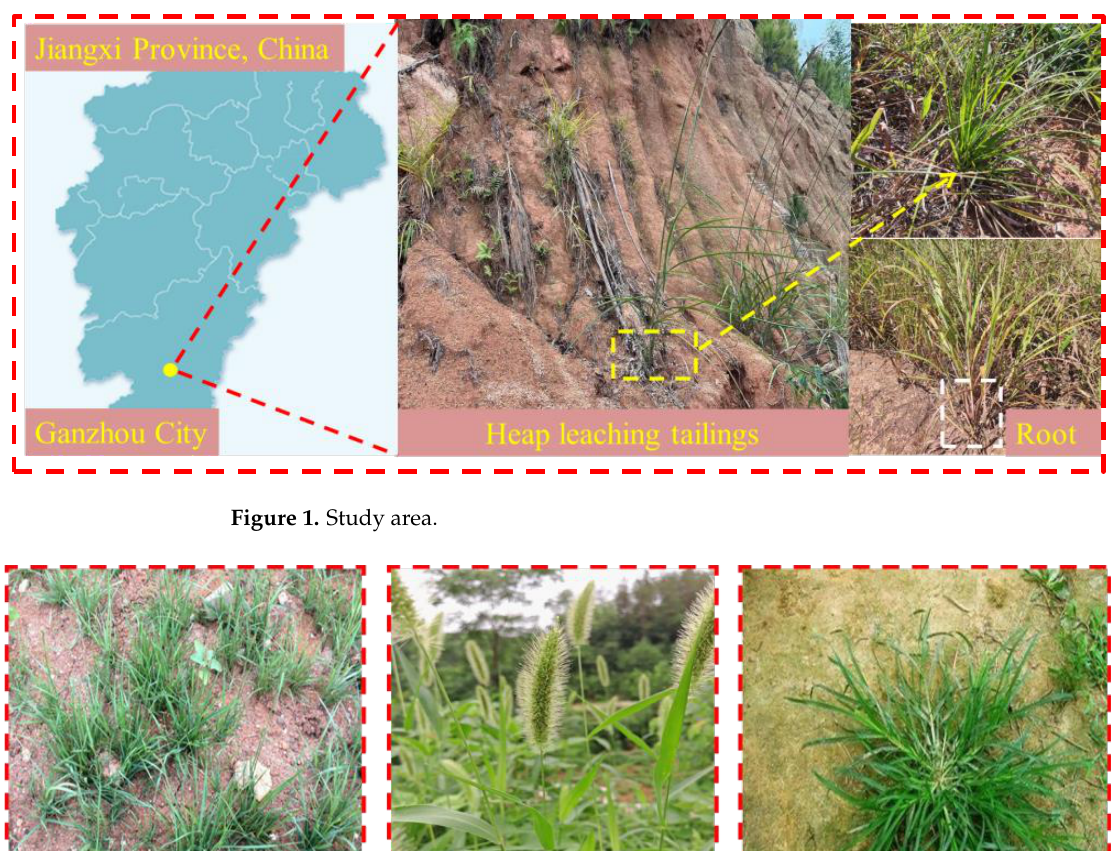
Figure 2. Vegetation sample.